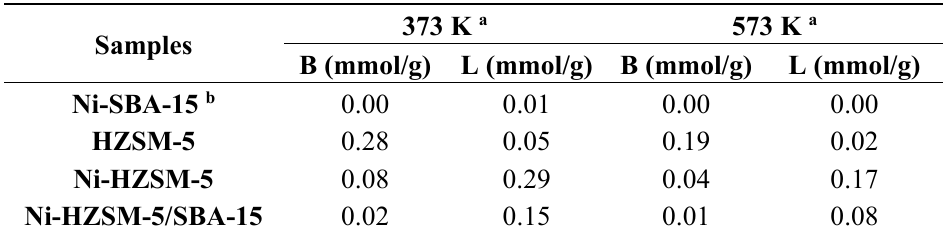
Table 2. Acidity of these catalysts obtained by